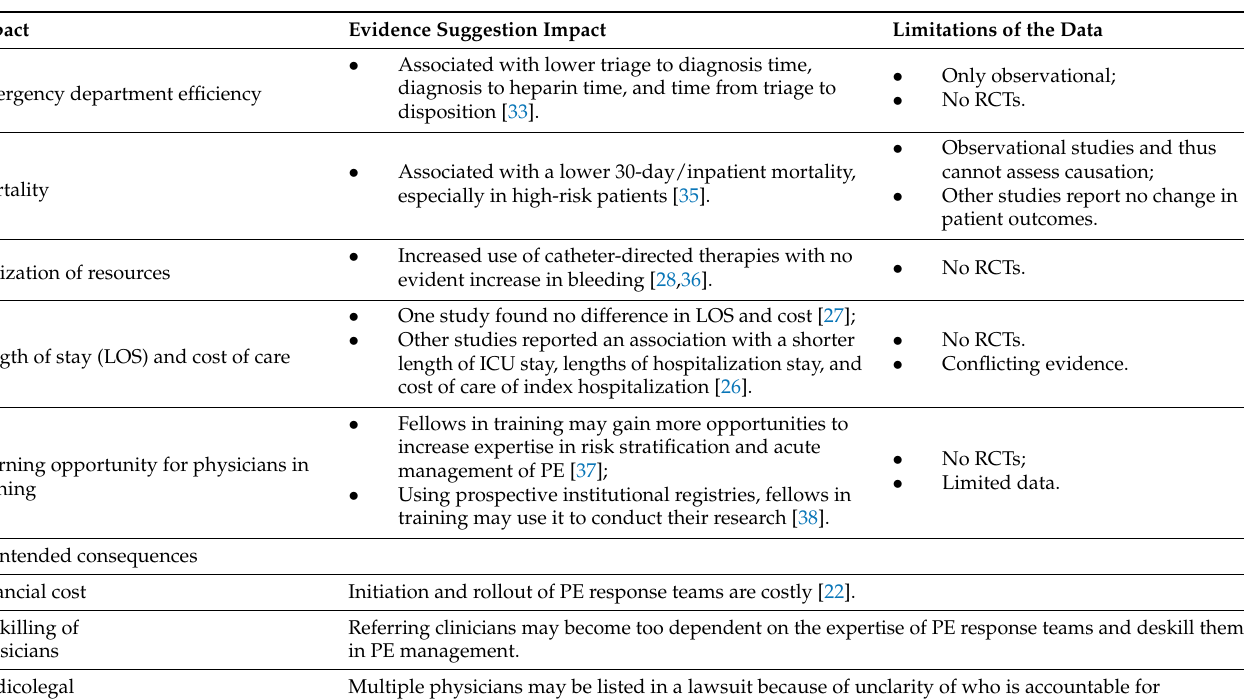
Table 1. Potential impacts and evidence suggesting the role of PE response teams to date [34]. ICU = intensive care unit; LOS = length of stay; PE = pulmonary embolism; RCT = randomized con- trolled